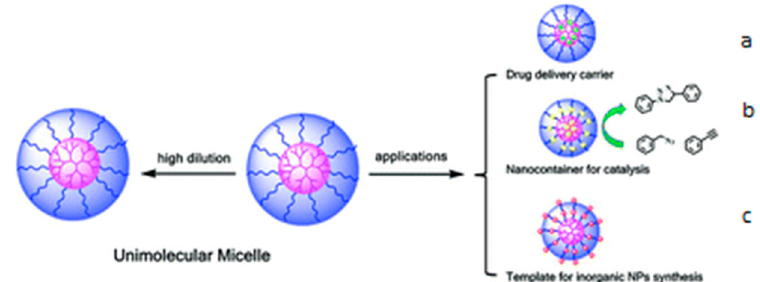
Figure 9. Proposed applications for covalent, unimolecular micelles ( a ) drug delivery, ( b ) catalysis, ( c ) templates for inorganic nanoparticle synthesis. Reproduced with permission from [52]. Copyright 2016 The Royal Society of Chemistry (RSC).